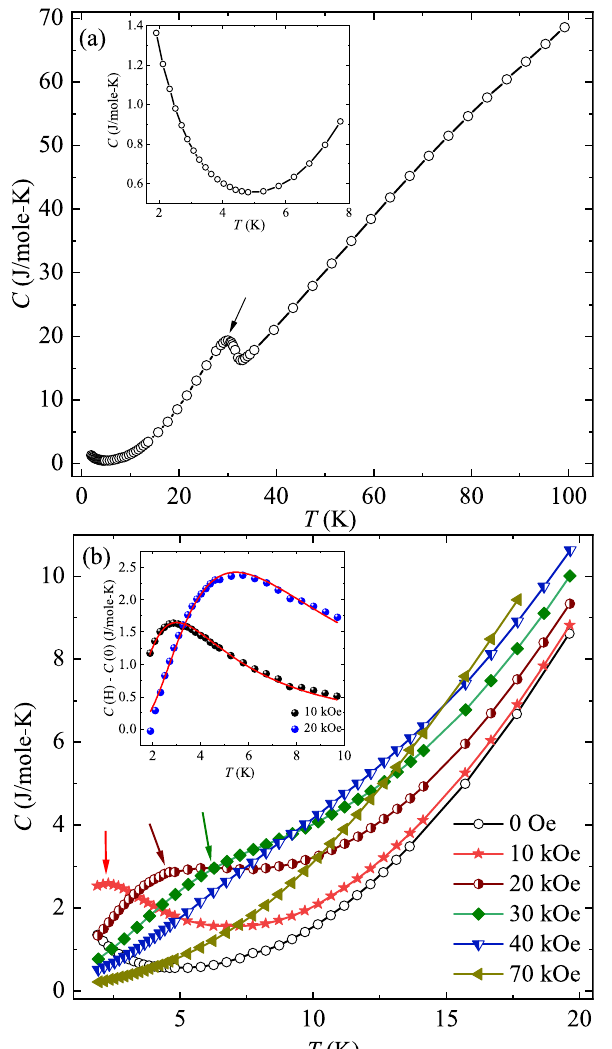
Figure 3. ( a ) T dependent C measured at zero field, with arrow showing the temperature of structural transition. The inset shows the same quantity below 10 K. ( b ) C versus T curves obtained at various applied H . The arrows show the emergence of broad hump. Inset: Two-level Schottky fitting obtained at 10 and 20 kOe